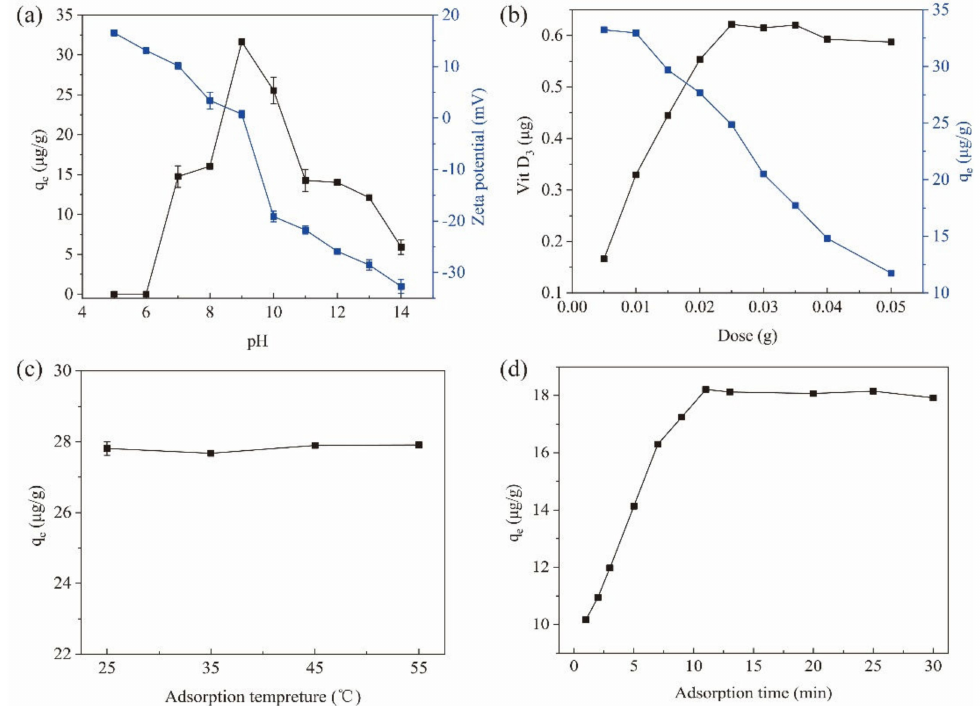
Figure 4. Effects of factors on the adsorption of VD 3 by Fe 3 O 4 @PPy. ( a ) pH value of sample, ( b ) adsorbent dose, ( c ) adsorption temperature, and ( d ) adsorption time. Data are expressed as the mean ± standard deviation ( n =